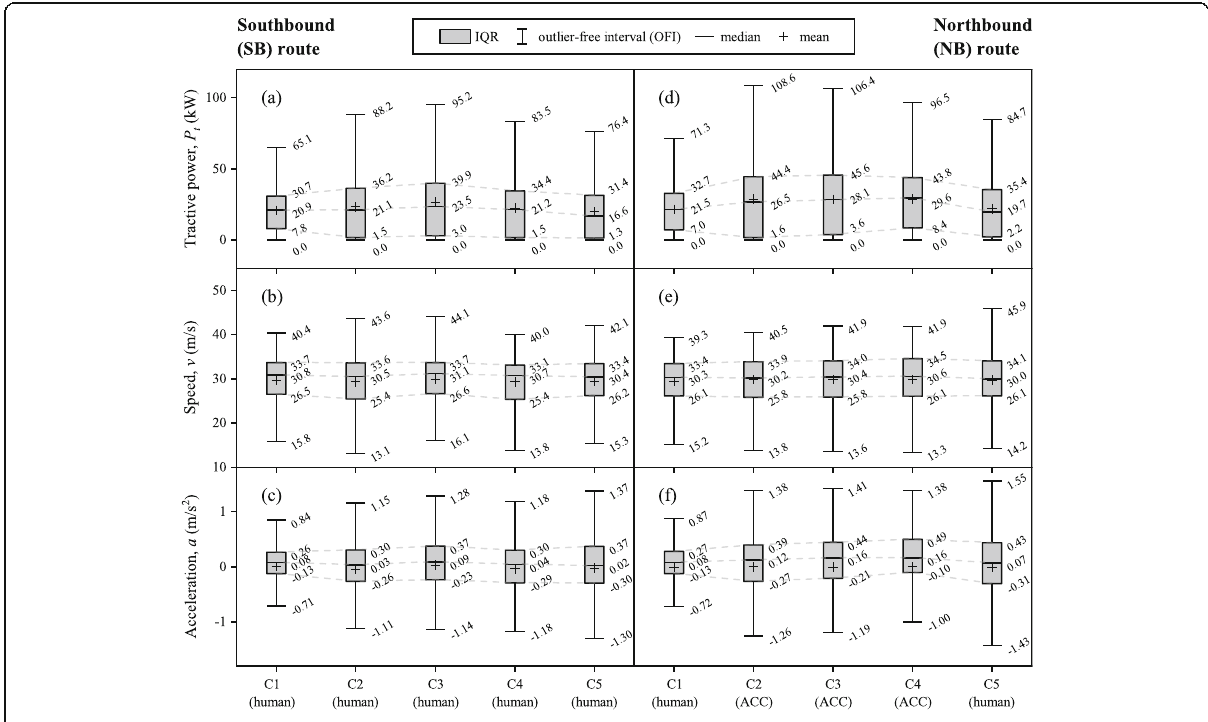
Fig. 6 Box plots of tractive power, speed, and acceleration